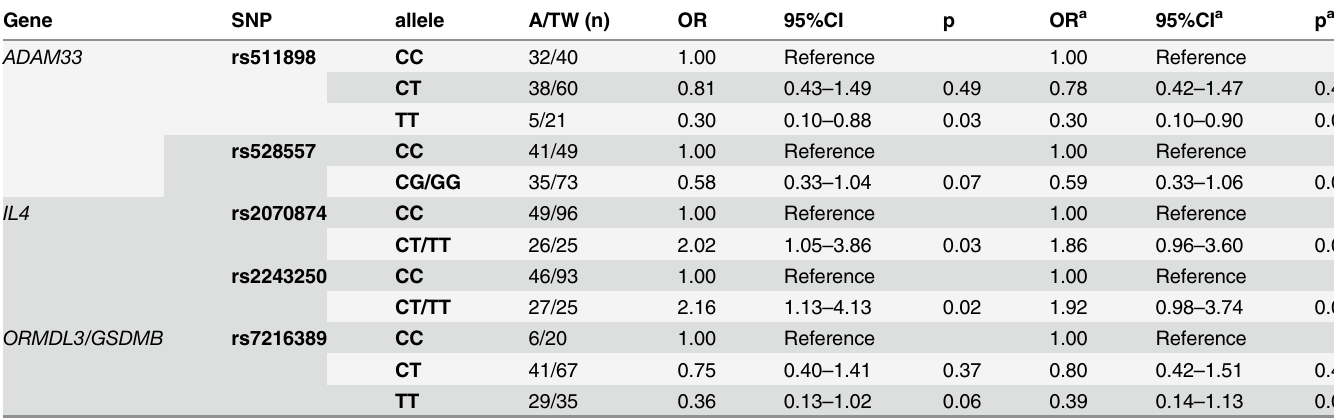
Table 2. Genetic variants associated with asthma in the ADEM